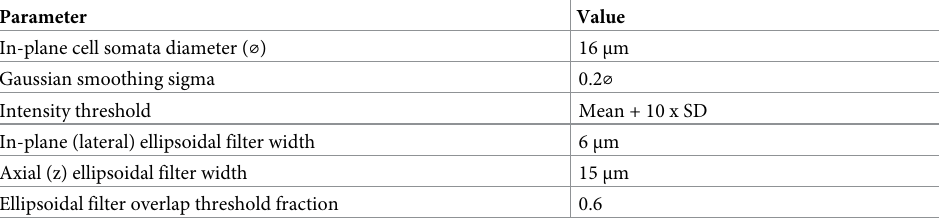
Table 1. Default cell detection